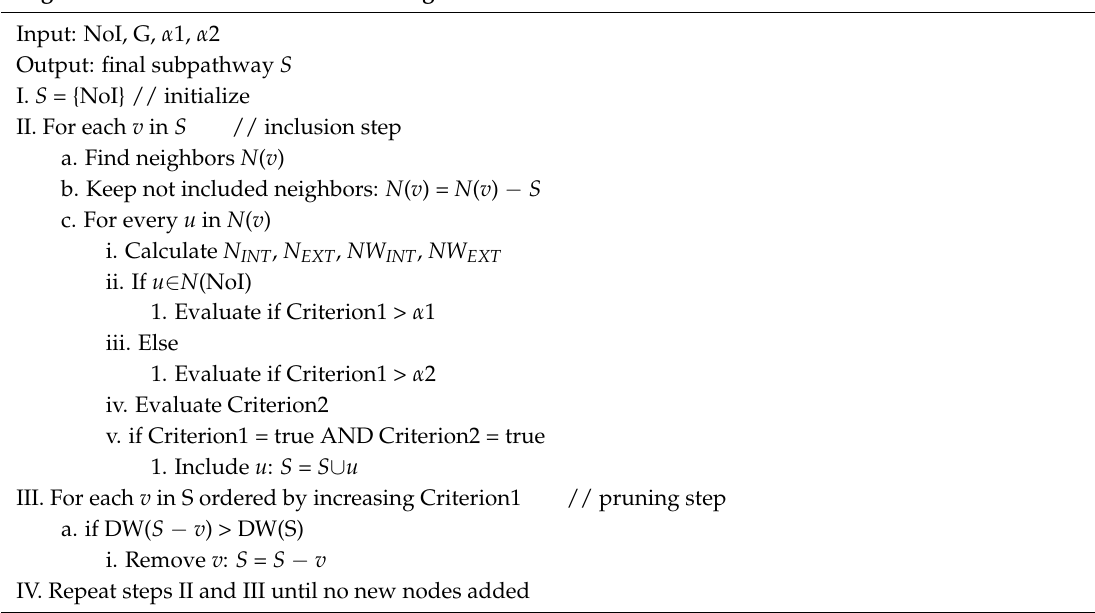
Algorithm 1. Pseudocode of PerSubs